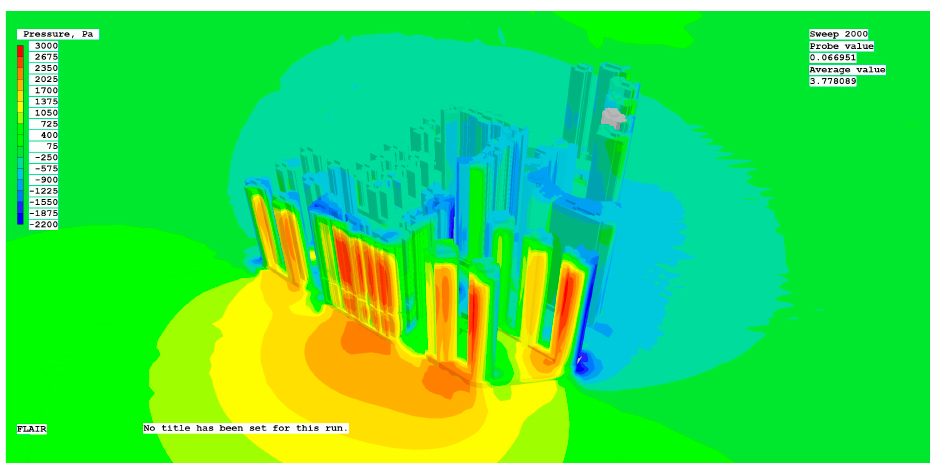
Figure A15. Instantaneous building surface pressure under typhoon conditions (the La Baie du Noble Fok On looks west).